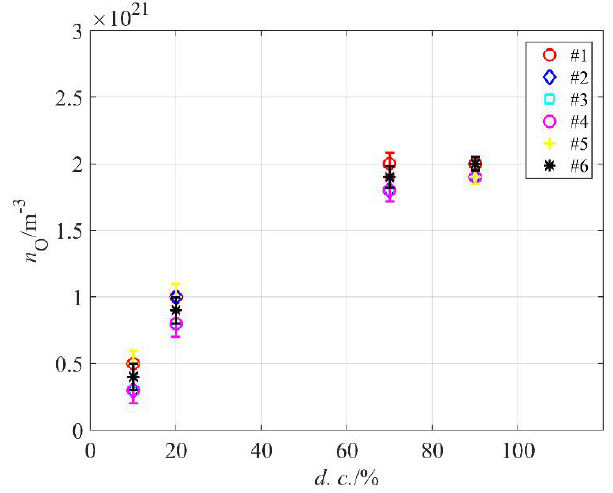
Figure 6. The O-atom density in air plasma at 80 Pa versus MW generator duty cycle.